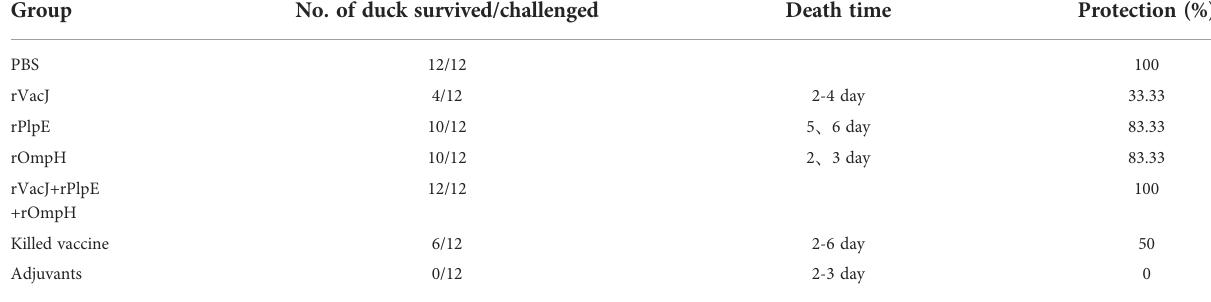
TABLE 1 The survival rate of ducks after P. multocida challenge.